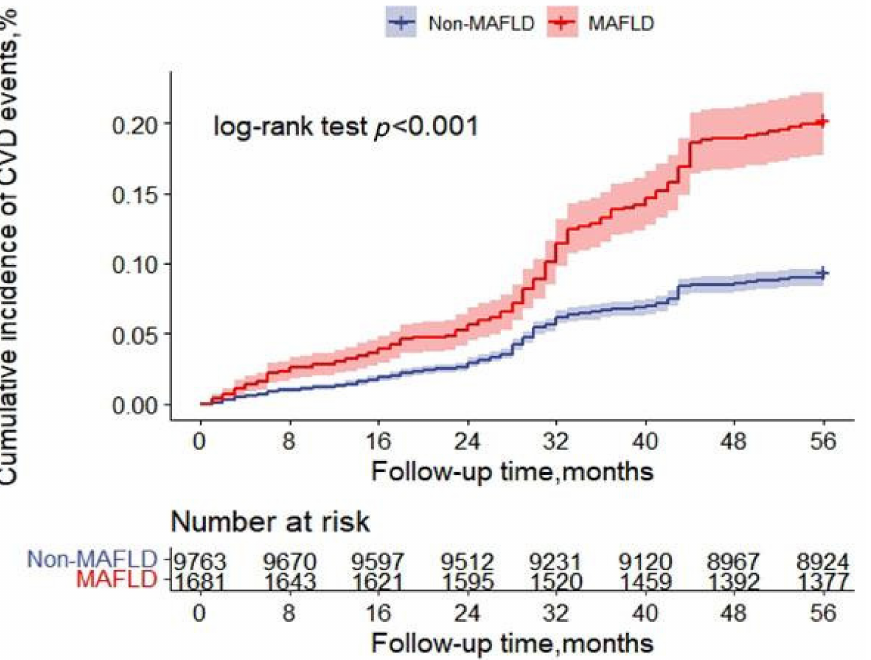
Figure 2. Kaplan–Meier estimates for cumulative cardiovascular disease incidence based on the presence of metabolic dysfunction-associated fatty liver disease (MAFLD, metabolic dysfunction- associated fatty liver; CVD, cardiovascular